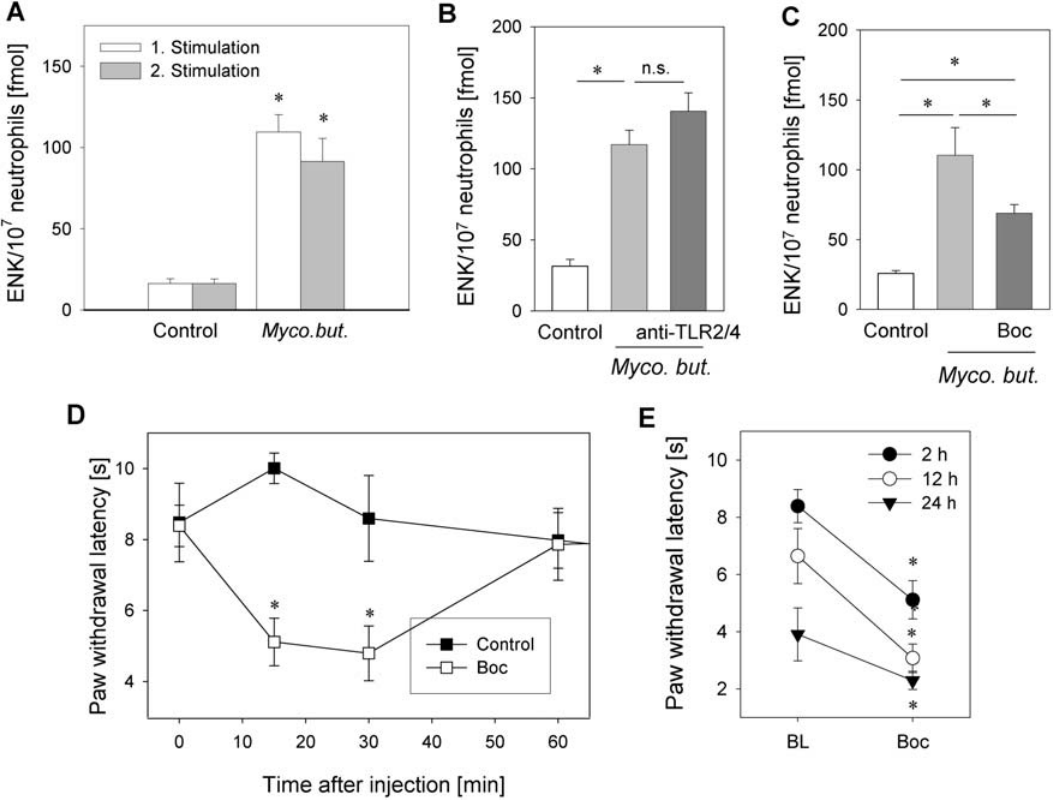
Figure 7. Tonic opioid peptide release through FPR stimulation reduces inflammatory pain. [ A ] Rat neutrophils were repeatedly stimulated with Mycobacterium butyricum ( Myco. but. 0.66 mg/ml) and Met-enkephalin (ENK) content was determined in supernatants (n=12–16; * p , 0.05, one way RM ANOVA, Student-Newman-Keuls Method). [ B, C ] Mycobacterium butyricum -induced Met-enkephalin release was unaltered by anti-TLR-2 and -TLR-4 antibodies ([ B ], anti-TLR-2/4 both 10 m g/ml, n=8–19), but was significantly reduced by FPR antagonist Boc-FLFLF ([ C ], Boc: 100 m M, n=7–11, both * p , 0.05 one way RM ANOVA, Student-Newman-Keuls Method. [ D ] Rats with 2 h complete Freund’s adjuvant inflammation were intraplantarly injected with Boc-FLFLF (Boc, 3 m g, [ D ], n=5–6) and nociceptive thresholds were determined (*p , 0.05 one way RM ANOVA, Duncan Method). Data are means 6 SEM. [ E ] Rats (n=6) with 2, 12 and 24 h complete Freund’s adjuvant inflammation were treated with 3 m g Boc intraplantarly and paw withdrawal latency was measured afterwards (* p , 0.05, Wilcoxon Signed Rank test compared to baseline